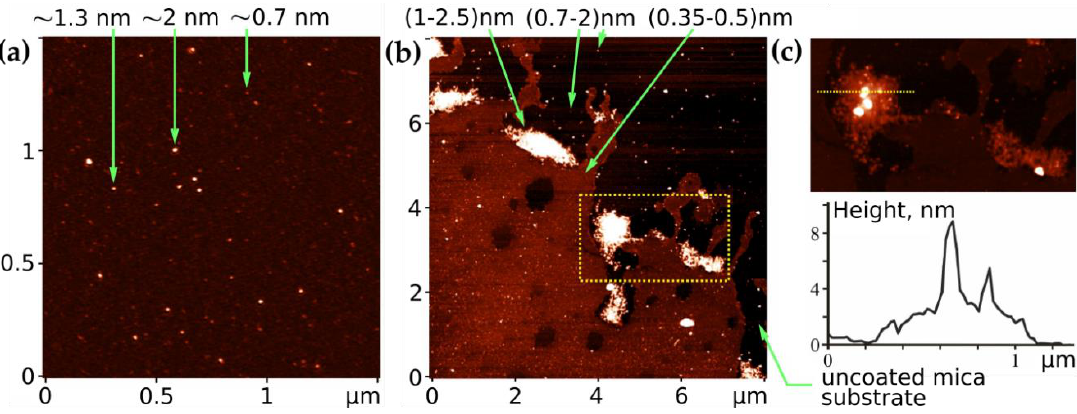
Figure 5. AFM images: the C 60 (concentration: 208 µ M) layer ( a ); the C 60 -Ber (208:208 µ M) layer ( b ). Numbers with arrows show the height of nano-objects. ( c ) A 3.5 × 2 µ m 2 fragment (highlighted in image ( b )) with reduced contrast (top) and its Z-profile along the marked line (bottom).